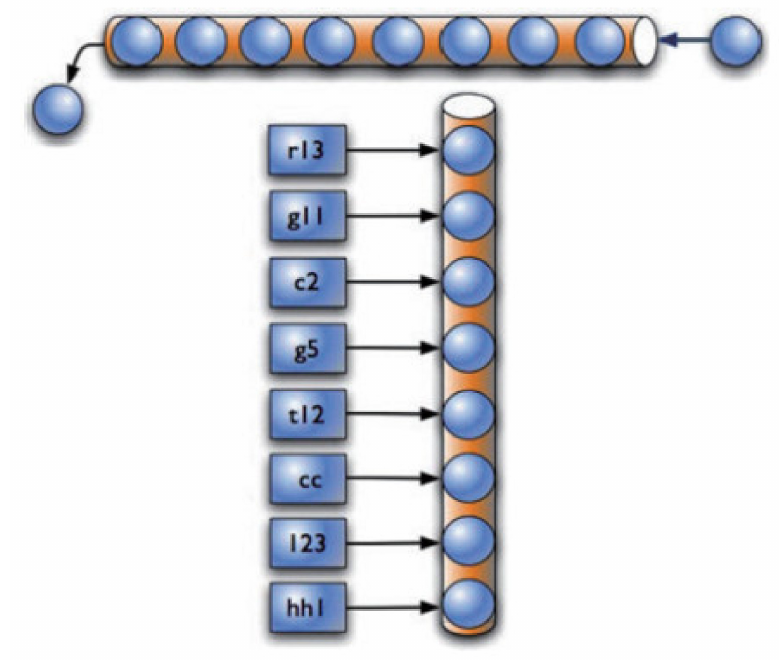
Figure 1. Data storage structure of MTConnect agent [13].